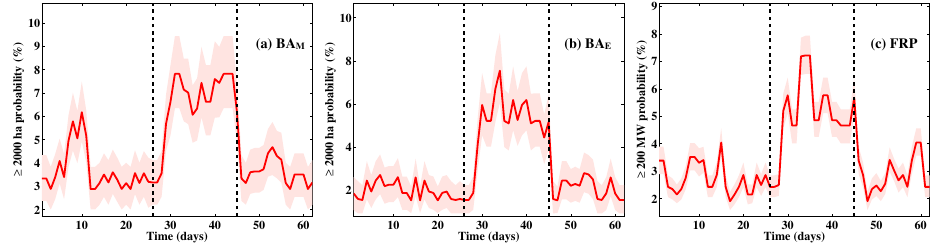
Figure 6. Probabilities of observing a ≥ 2000ha wildfire calculated from the BA M (a) and BA E (b) data sets and probabilities of observing a ≥ 200MW wildfire calculated from the FRP data set (c) as a function of time for the 2003 July–August period nearest the largest wildfire occurring in Portugal this season. Black dashed lines show the beginning and the end of the wildfire event. In light shaded red are the 90% confidence intervals.